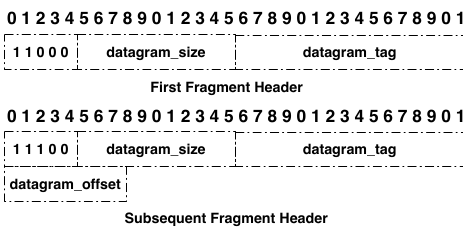
Figure 1. 6LoWPAN header defined by RFC